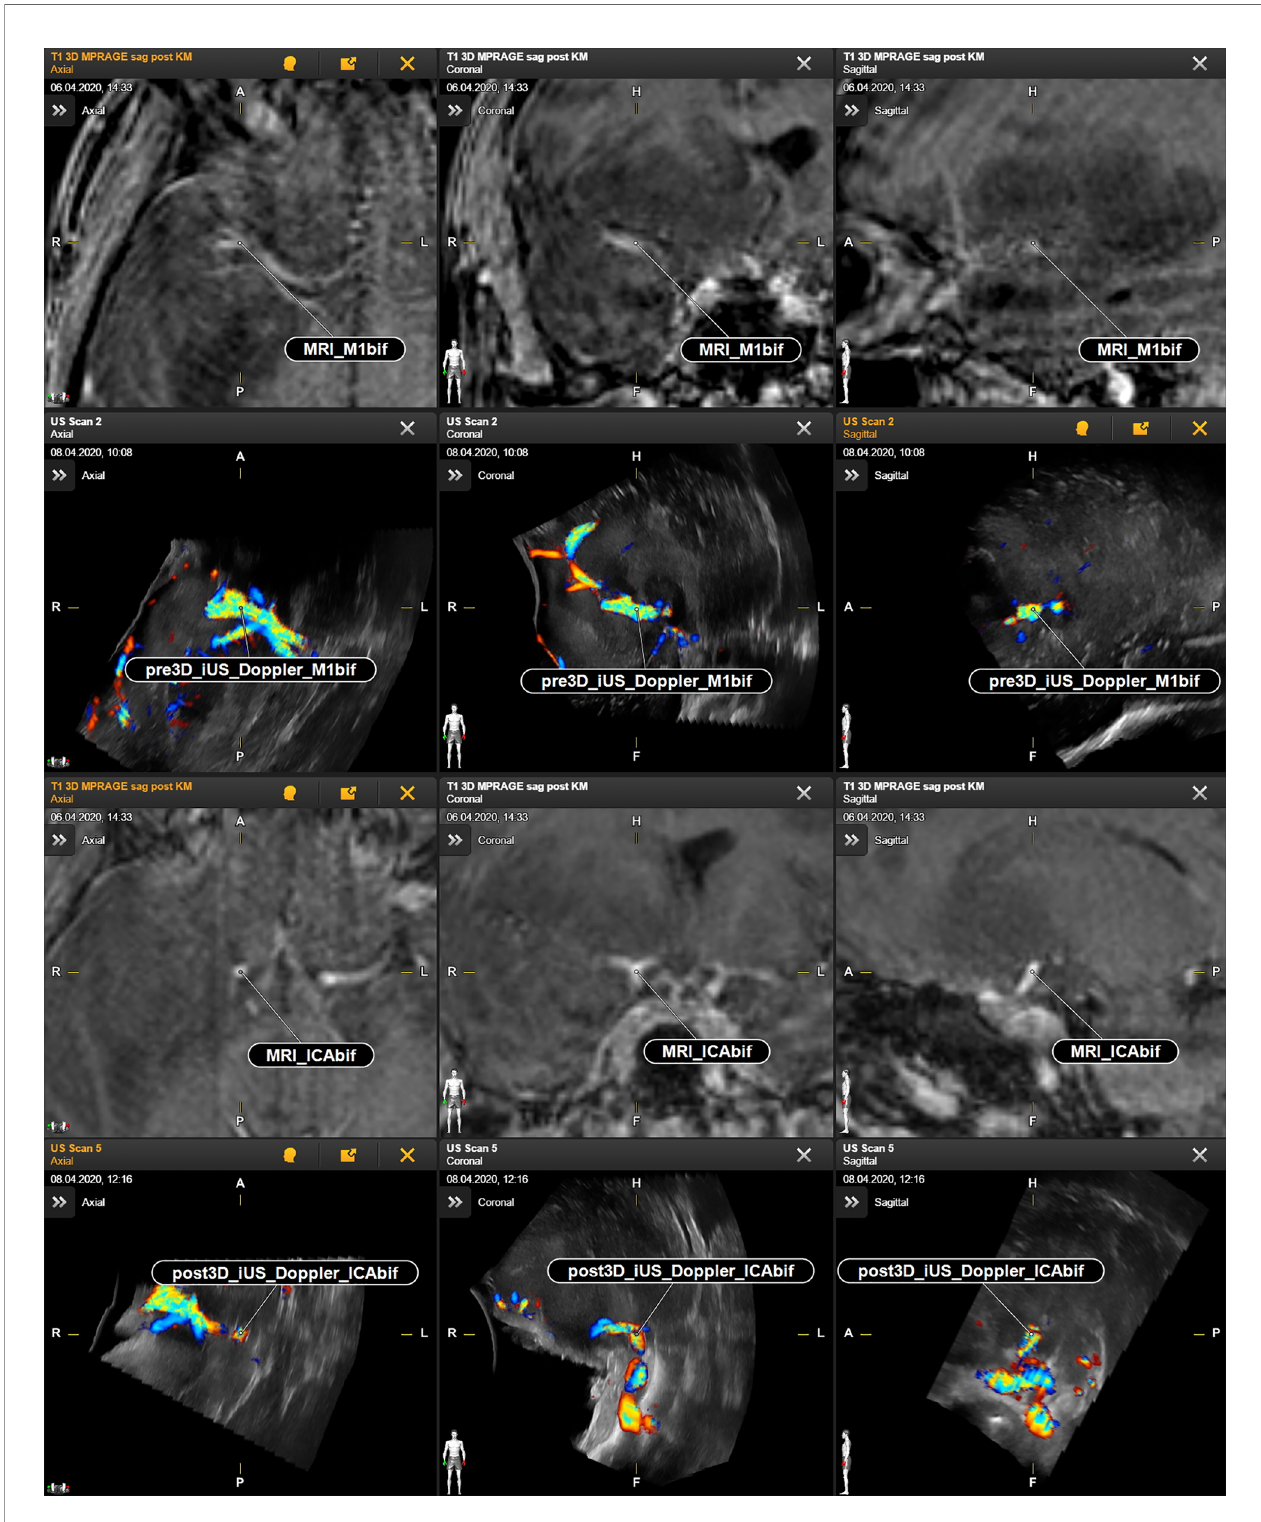
FIGURE 1 | Case no. 2. Identi fi cation of vascular anatomic landmarks in MRI and navigated reformatted 3D iUS Doppler. First and second row: preoperative MRI and corresponding pre-resectional 3D iUS Doppler in axial, coronal, and sagittal plane. Third and fourth row: preoperative MRI and corresponding post-resectional 3D iUS Doppler in axial, coronal, and sagittal plane. CAbif, internal carotid artery bifurcation; M1bif, M1bifurcation; pre3D iUS Doppler, pre-resectional 3D iUS Doppler; post3D iUS Doppler, post-resectional 3D iUS Doppler.